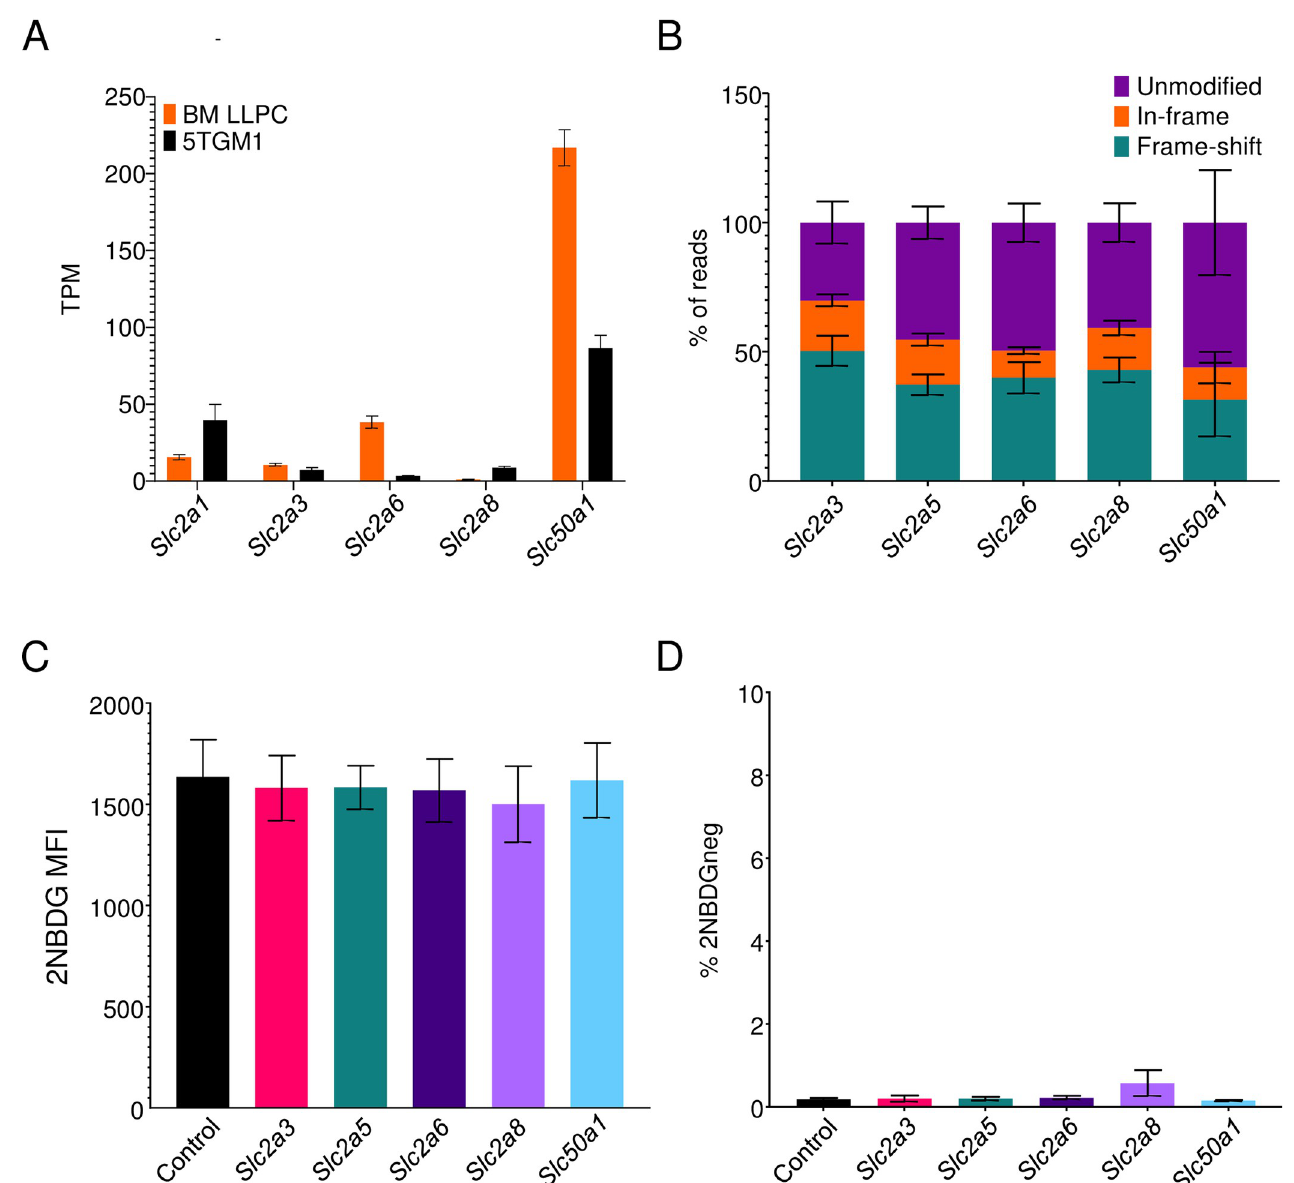
Fig 5. 2NBDG uptake takes place independently of sugar transporters. (A) Transcripts per million kilobase (TPM) values of sugar transporters in ex vivo bone marrow plasma cells (orange) and 5TGM1 cells (black). Mean values +/- SEM are shown. (B) Quantification of gene modifications in gRNA-transduced cultures. Exons of indicated genes were PCR amplified and sequenced to assay for in-frame and frame shift mutations. Mean values +/- SEM shown for each of the genes and modifications within it. Pooled data from three experiments. (C) 2NBDG uptake in sugar transporter deleted cultures. 5TGM1-Cas9 cells were transduced with control gRNA (black) or gRNAs targeting Slc2a3 (pink), Slc2a5 (blue), Slc2a6 (violet), Slc2a8 (purple), and Slc50a1 (cyan). MFIs across three independent experiments are quantified and displayed with SEM. No significant differences observed with Brown-Forsyth and Welch one-way ANOVA multiple comparisons test. (D) Frequency of 2NBDG-negative cells for groups in (C). 2NBDG- gate drawn based on control cells cultured without 2NBDG in complete media. Mean values +/- SEM are shown. No significant differences observed with Brown-Forsyth and Welch one-way ANOVA multiple comparisons